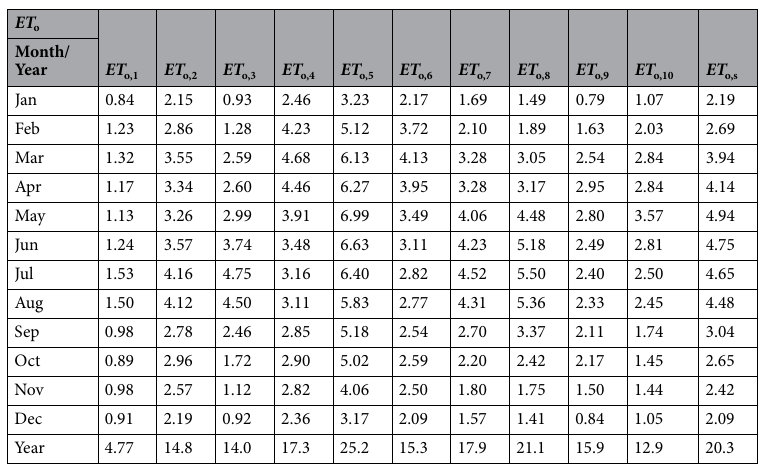
Table 4. Standard deviation values of ET o,i ( i = 1 to 10) and ET o,s at the monthly